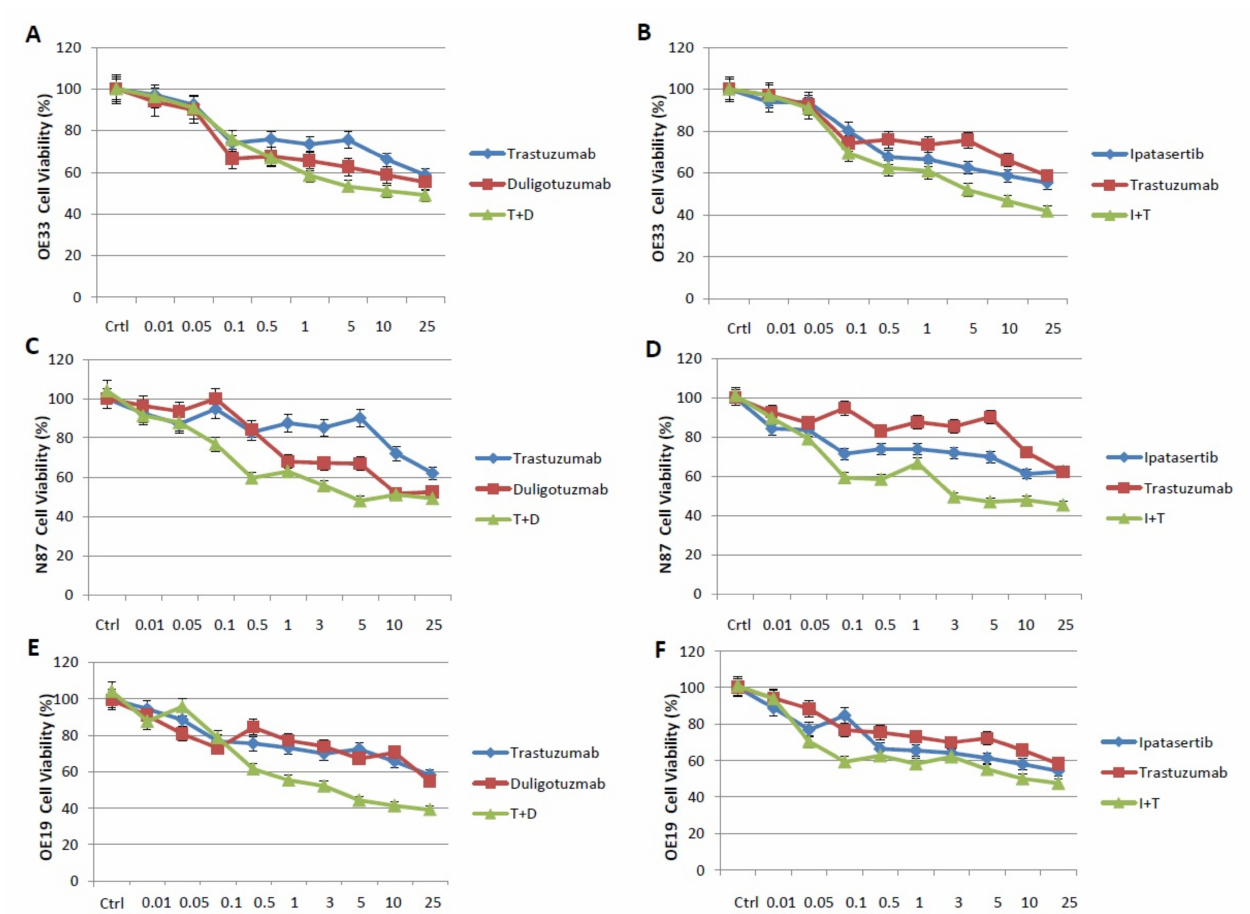
Figure 1. Effect of Trastuzumab, Ipatasertiband Duligotuzmabon cellproliferationin a panel of human gastriccancercelllines: OE33 ( A , B ), N87 ( C , D ) and OE19 ( E , F ). Cellsweretreatedwith differentconcentrationof eachdrug, assingle agent and in combination(Trastuzumaband Duligotuzumab, T+D; Ipatasertiband Trastuzumab, I+T), for 72 h and evaluatedfor proliferationby MTT staining, asdescribedin Materialsand Methods. The resultsare the medianof threeseparate experiments, eachperformedin